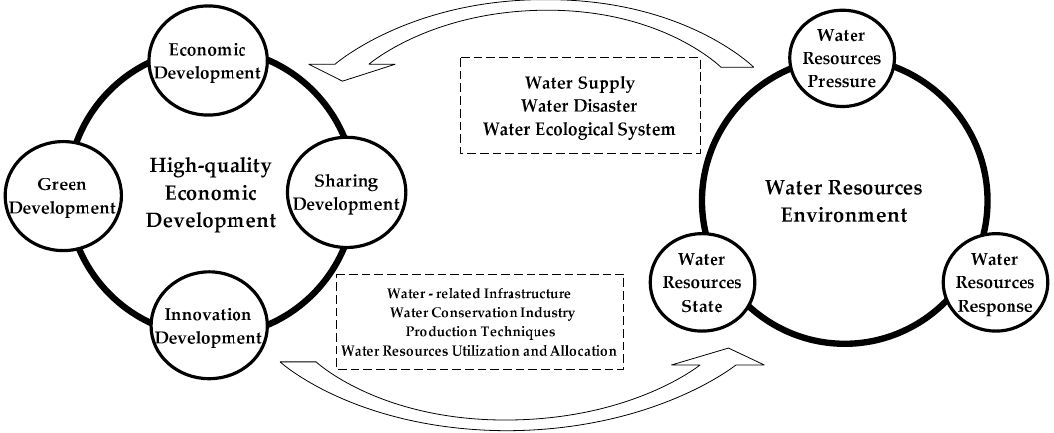
Figure 1. Synergy mechanism between the water resources environment and high-quality economic